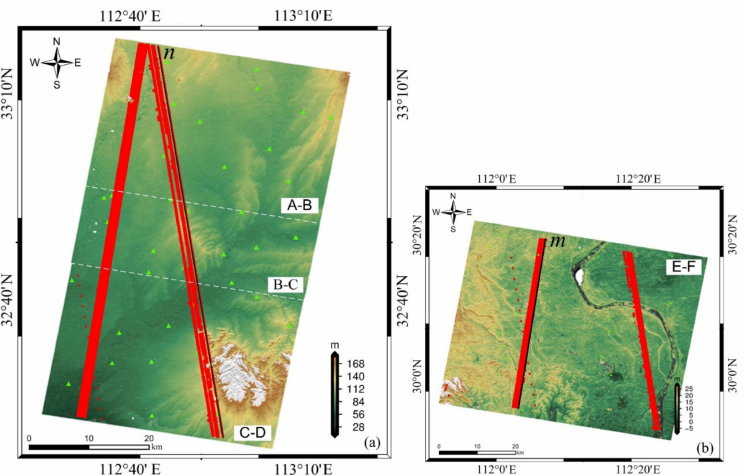
Figure 5. DEM products obtained after the calibration process: ( a ) the DEM results corresponding to interferometric pairs A–B, B–C and C–D and ( b ) DEM results corresponding to interferometric pair E–F. In ( a , b ), the green triangles show the GCPs and the red points show the ICESat laser